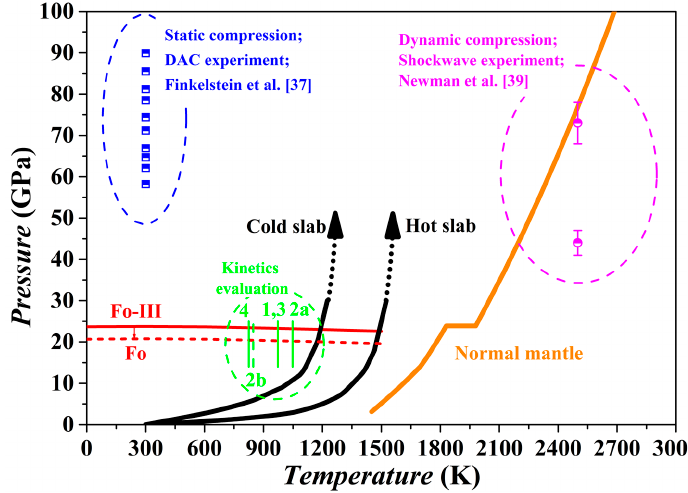
Figure 15. Formation P - T conditions of metastable Fo-III. The P - T profile of the cold slab or hot slab is sketched according to Thompson [93], while that of the normal mantle is from Anderson [94]. The lowest temperatures for any possible phase transition from the Fo-rich Ol to its equilibrium phase or phase assemblage (from ~14 to ~24 GPa), as estimated in Sung and Burns [1], Wu et al. [26], Kirby et al. [6] and Devaux et al. [7], are shown as short lines 1, 2 (2a for hydrostatic condition and 2b for nonhydrostatic condition), 3 and 4, respectively. The potential P overestimate for the Fo/Fo-III phase boundary caused by the GGA method is indicated by the tiny red